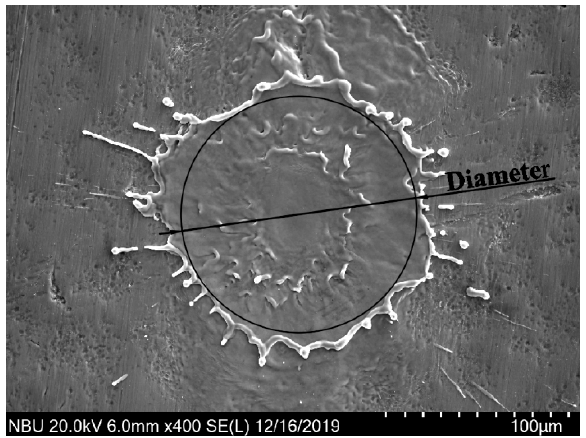
Figure 2. Diameter of the splash area were used to estimate the diameter of laser spot.